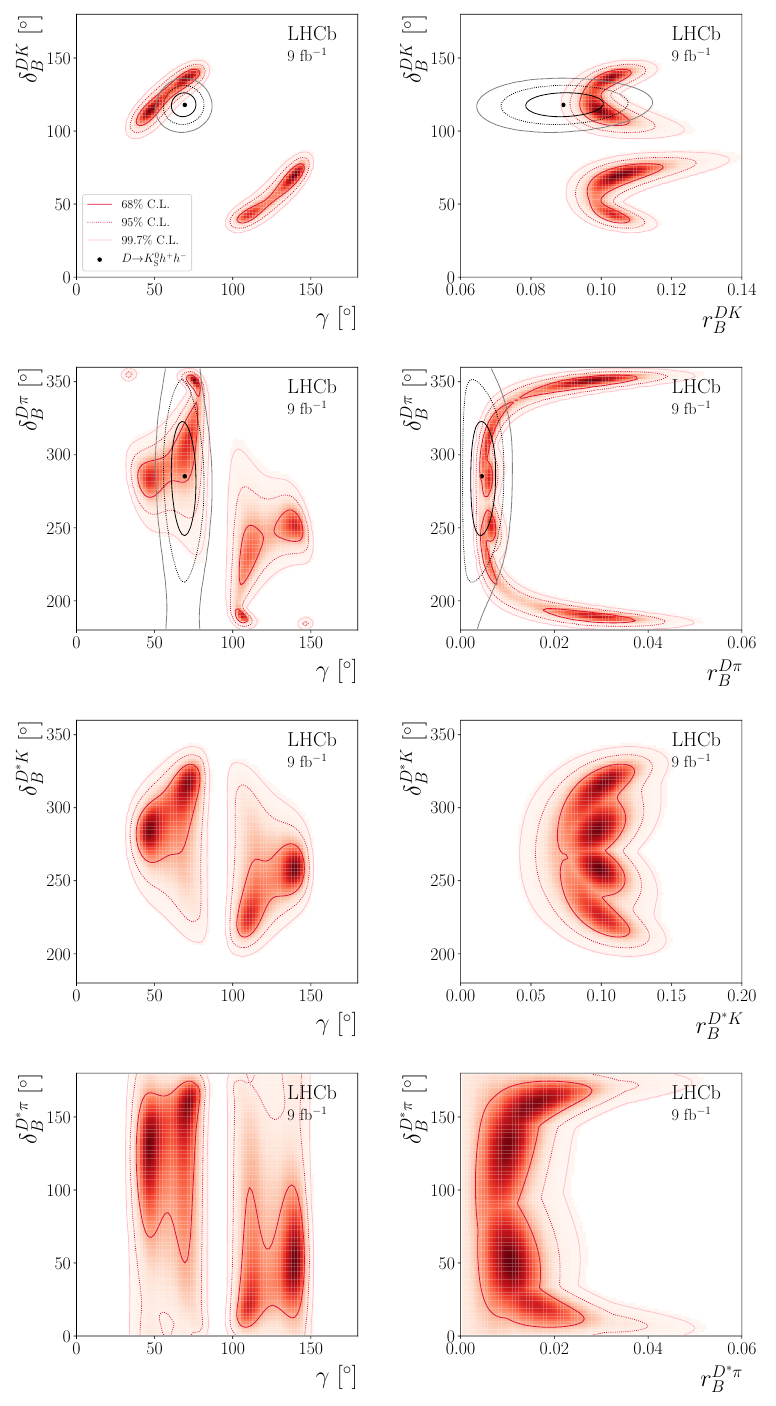
Figure 6 . Confidence regions for the (top row) B − → DK − , (second row) B − → Dπ − , (third row) B − → D ∗ K − , and (fourth row) B − → D ∗ π − fundamental parameters. The B − → Dh − with D → K 0 h + h − contours from ref. [5] are also S